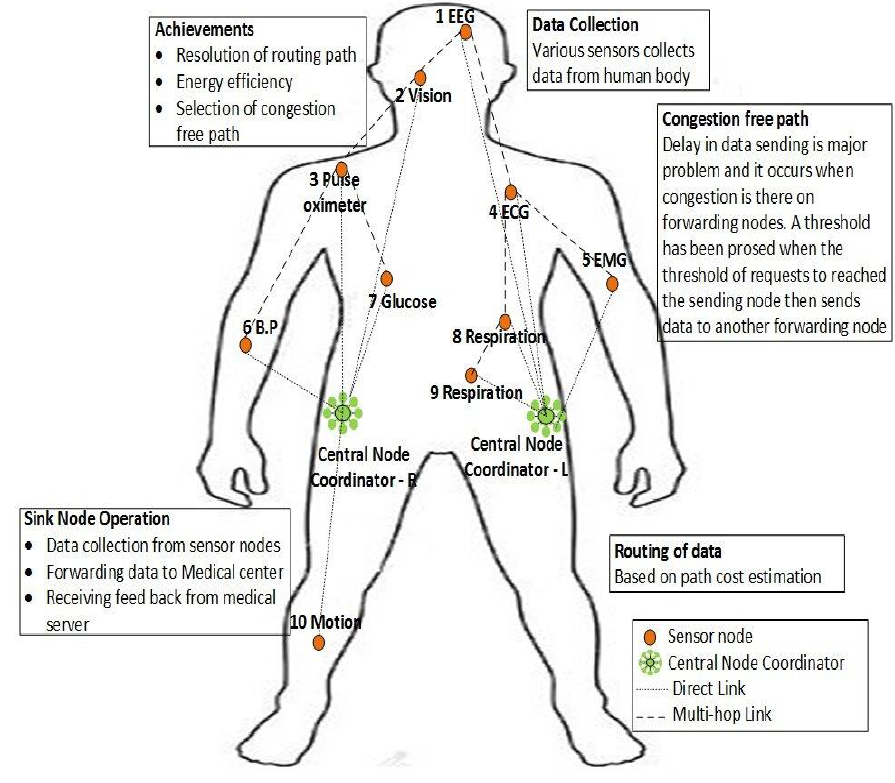
Figure 3. Node deployment in EHCRP.